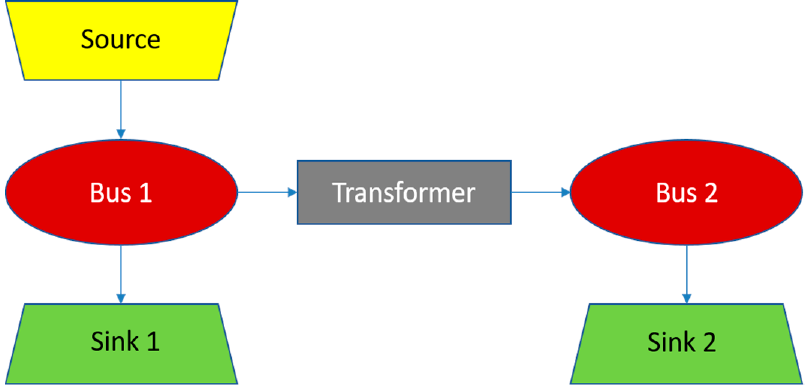
Figure 8. Illustration of a simple (Open Energy Modelling Framework) Oemof energy system. Adapted from Oemof Documentation [114].